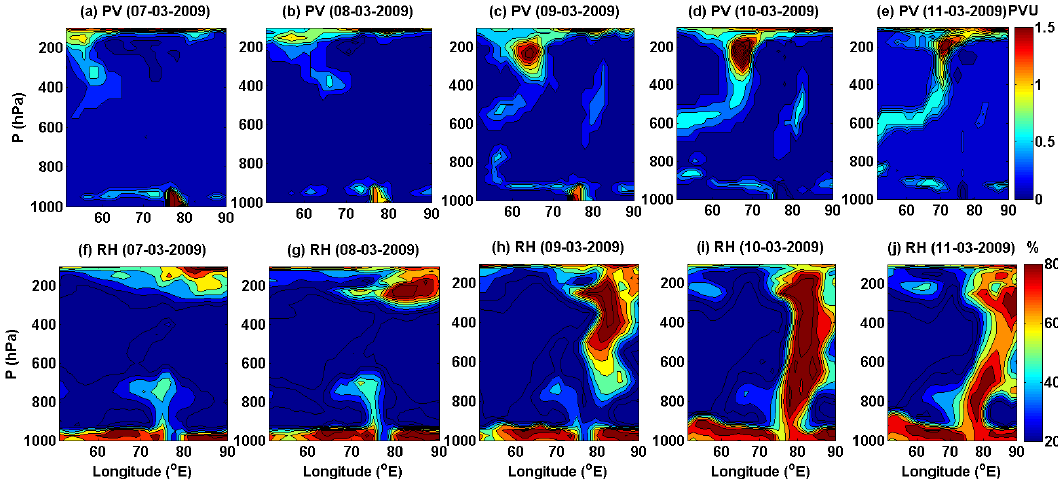
Figure 2. Longitude-height cross sections PV (a–e) and RH (f–k) at 13.5 ◦ N during 7–11 March